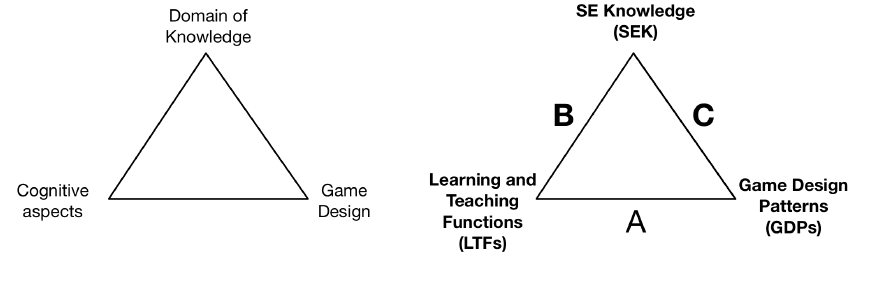
Figure 1. The ABC triangle.